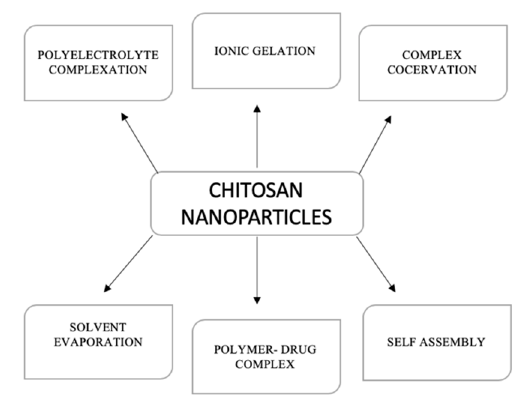
Figure 3. Chitosan-based nanoparticles’ synthesis.